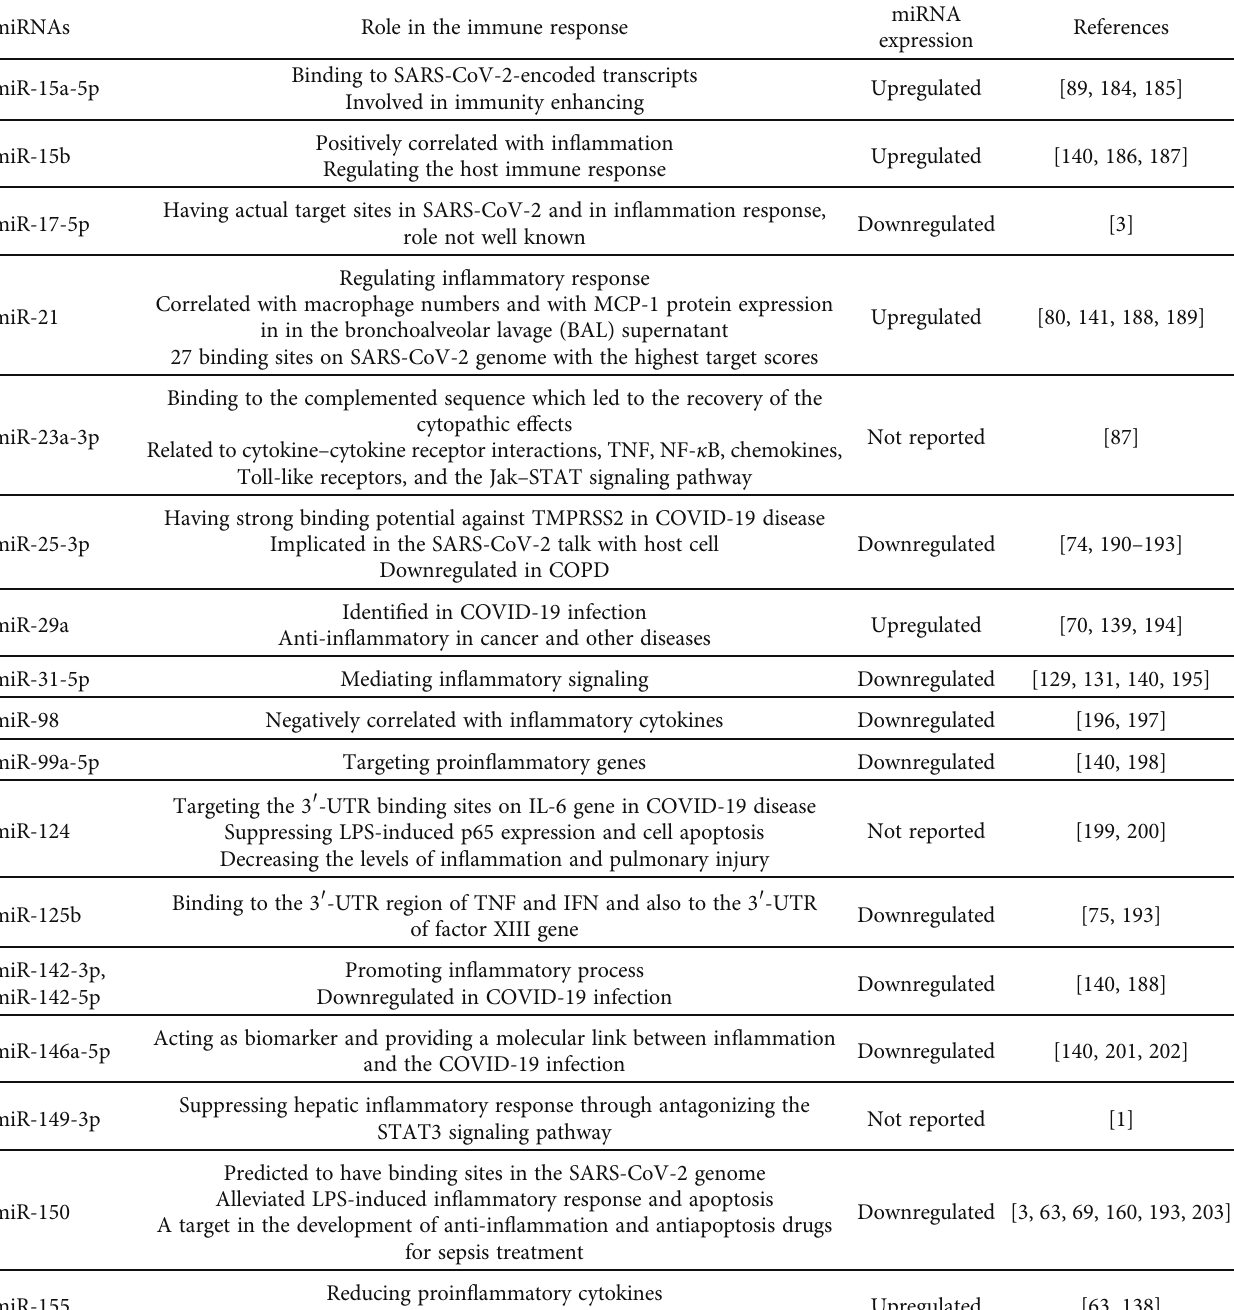
Table 1: COVID-19-associated miRNAs involved in immune